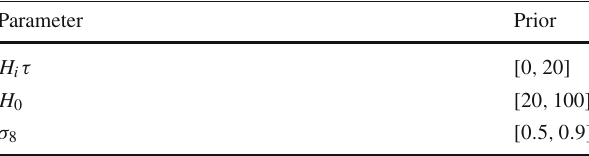
Table 1 We choose uniform priors defined over wide ranges for all the parameters Parameter Prior